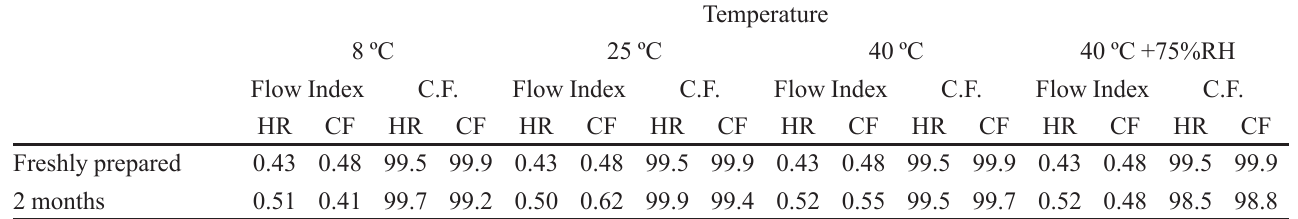
TABLE V - Different rheological properties of base